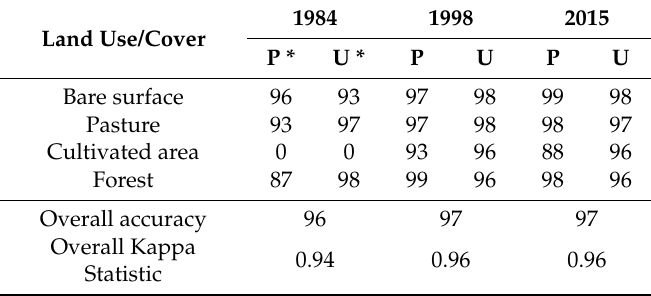
Table 3. Land use/cover classification accuracies (%) for 1984, 1998, and 2015.